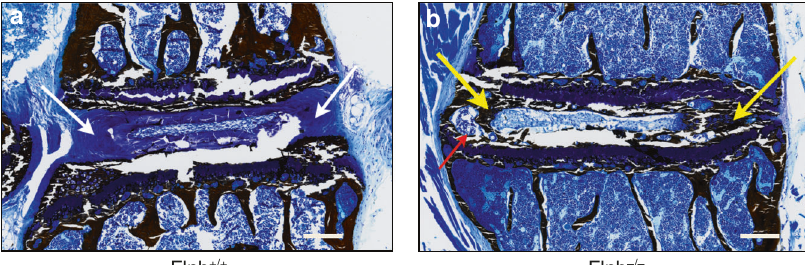
Fig. 1 Flnb − / − IVD exhibits ectopic mineralization. a , b P21 IVD plastic sagittal sections with Von Kossa staining. a Flnb + / + IVD exhibiting blue – violet fi brocartilage in AF IVD tissue (white arrows). b Flnb − / − IVD exhibits black – brown staining in the AF representing mineralization of the AF tissue (yellow arrows). AF also exhibits the characteristics of trabecular bone, an indication that it is undergoing full ossi fi cation. n = 3, Representative image of T7-T8 IVD in individual